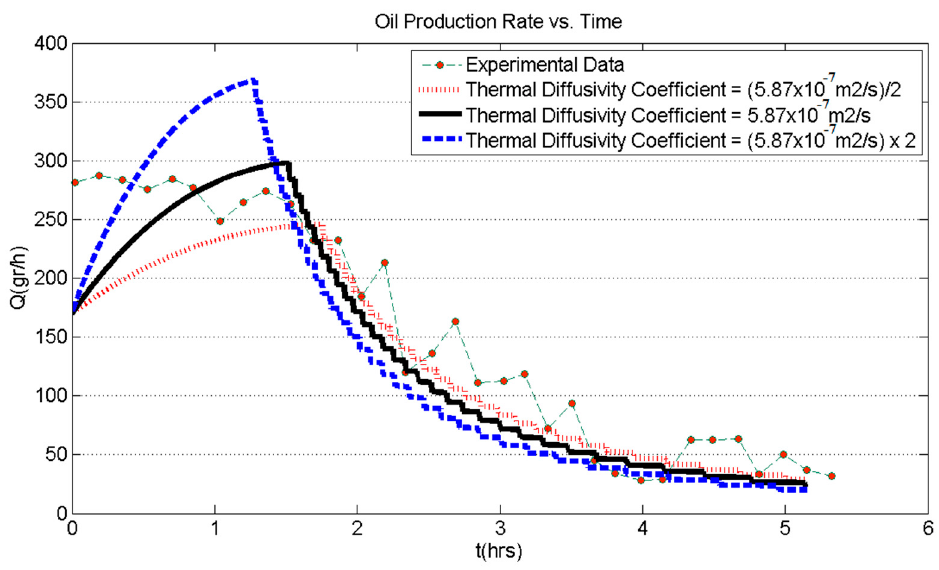
Figure 11. Study on the effects on thermal diffusivity variation on oil production rate in the present SAGD model.